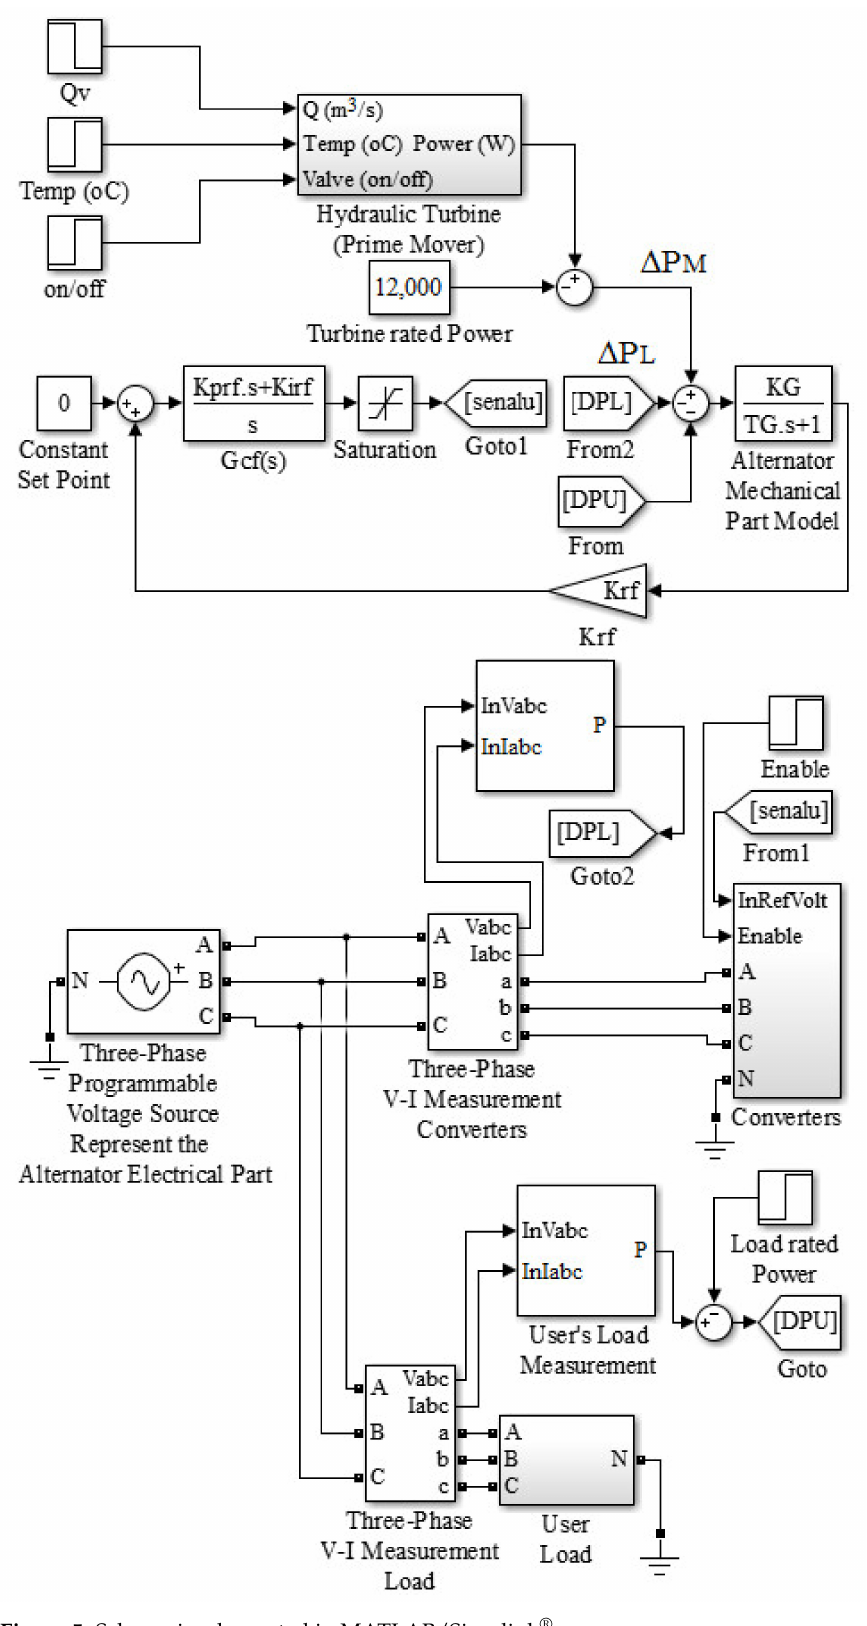
Figure 5. Scheme implemented in MATLAB/Simulink ®